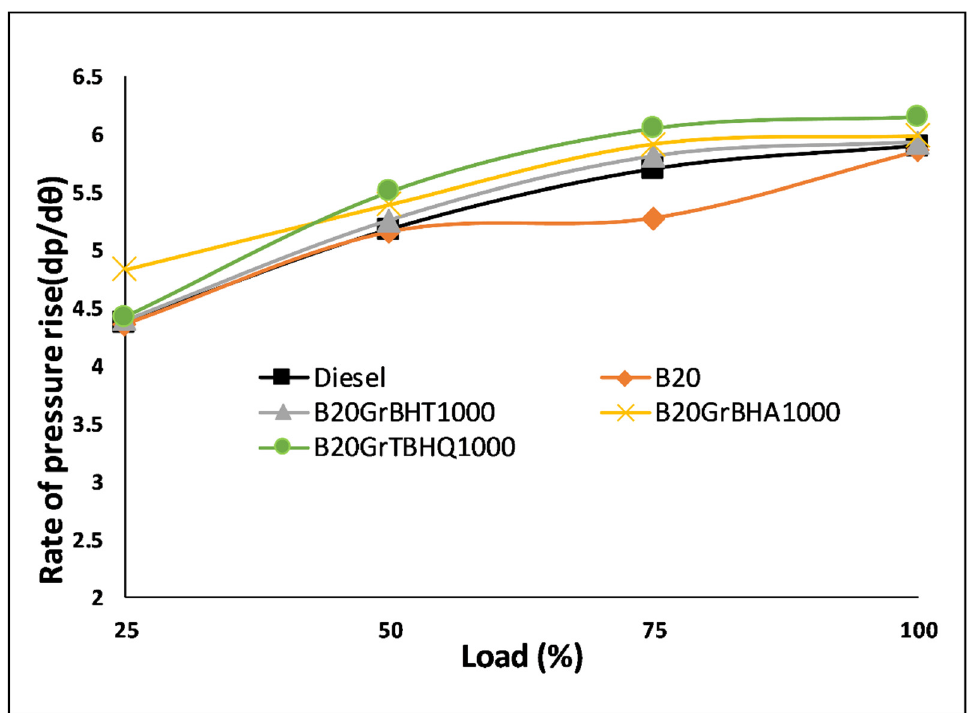
Figure 7. Deviation of pressure rise rate with crank angle.